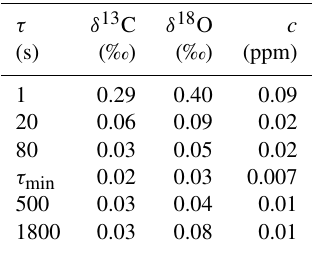
Table 5. Allan deviation σ A for different averaging times τ , with the minimum Allan deviation for τ min ≈ 290 s for both δ values and 170s for CO 2 concentration